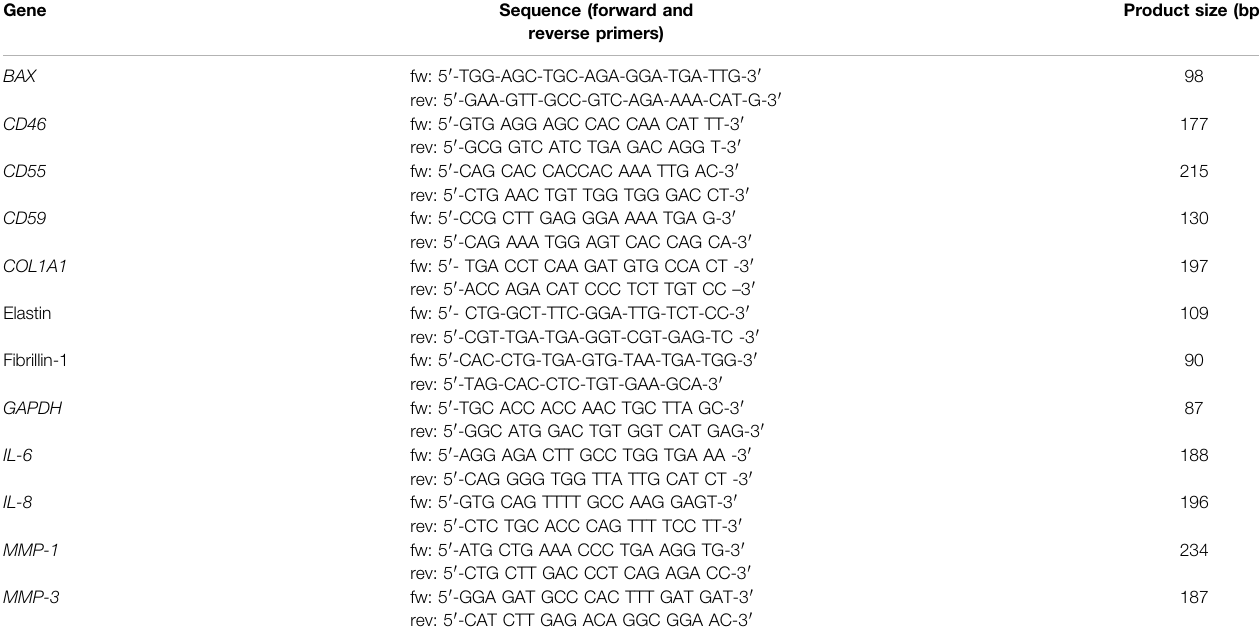
TABLE 1 | Human oligonucleotide primers used for qRT-PCR. Primers with shown sequence were custom designed. fw: forward; rev: reverse. Gene Sequence (forward and reverse